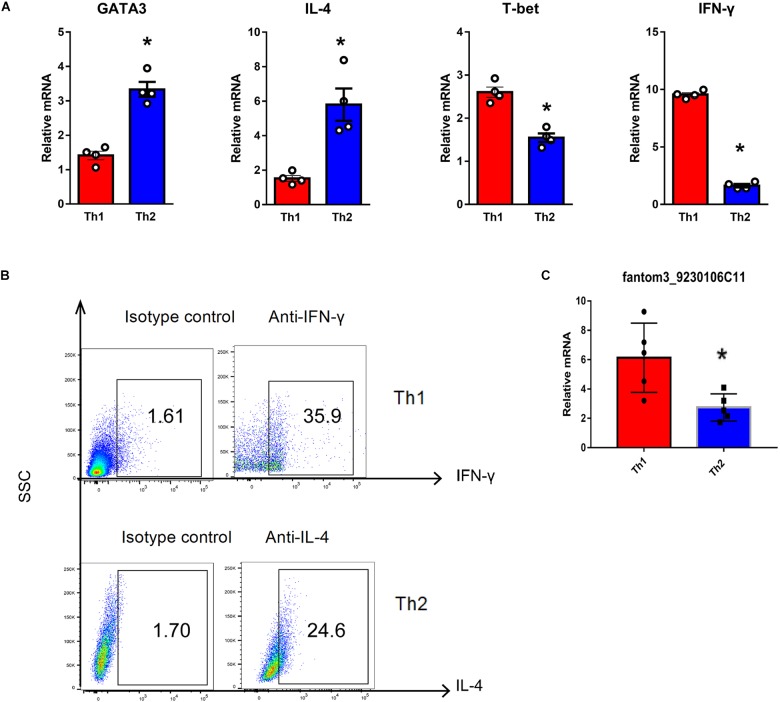
Quantification of LncRNA in Th1 and Th2 cells in vitro. (A) Typical cytokines and transcription factors for Th1 or Th2 were measured using qRT-PCR. Th1 cells exhibited elevated T-bet and IFN-γ levels. In contrast, Th2 cells expressed higher levels of Gata-3 and IL-4. In each group, 4 samples were analyzed. (B) Intracellular cytokines in Th1 and Th2 cells were measured by flow cytometry. Representative result for 3 independent experiments. (C) LncRNA fantom3_9230106C11 was measured in Th1 and Th2 cells in vitro using qRT-PCR. In each group, 5 samples were analyzed. ∗p < 0.05.